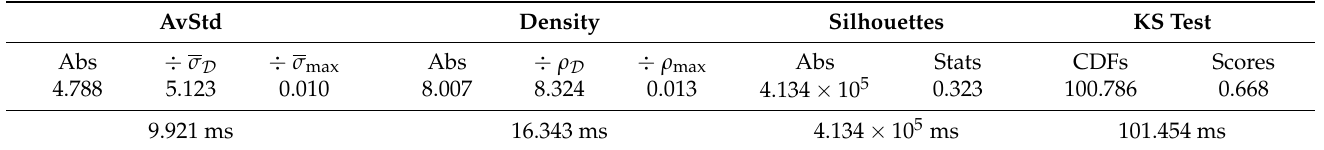
Table 9. Battery 2 execution times of the quantifiers (all values in milliseconds,